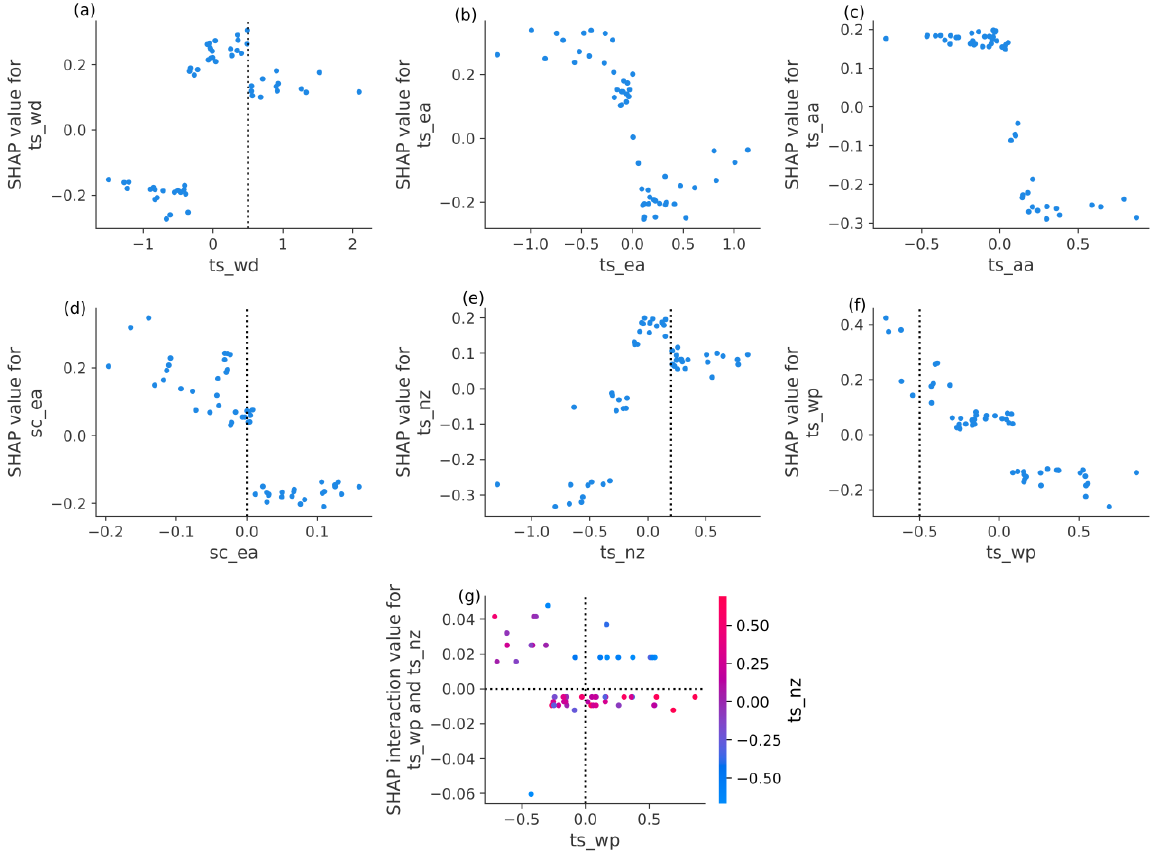
Figure 4. The global ( a ) and local ( b ) feature importance in all samples. Each dot in ( b ) represents one sample, and the colors of the dots represent the values of the sample features (also known as feature values).